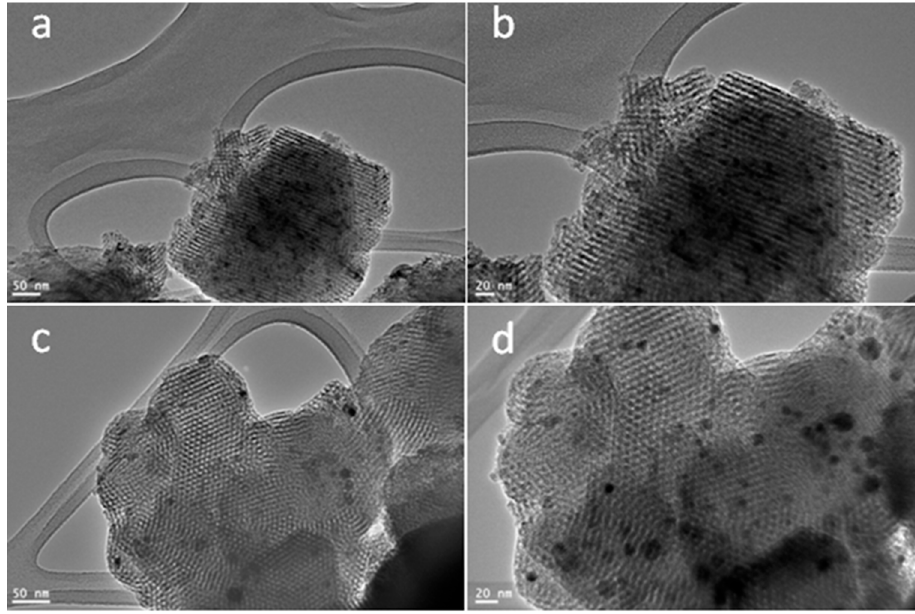
Figure 7. TEM image of fresh S15 and used Ni/S15 catalyst (( a , b ) for fresh S15, ( c , d ) for loaded Ni/S15 catalyst).